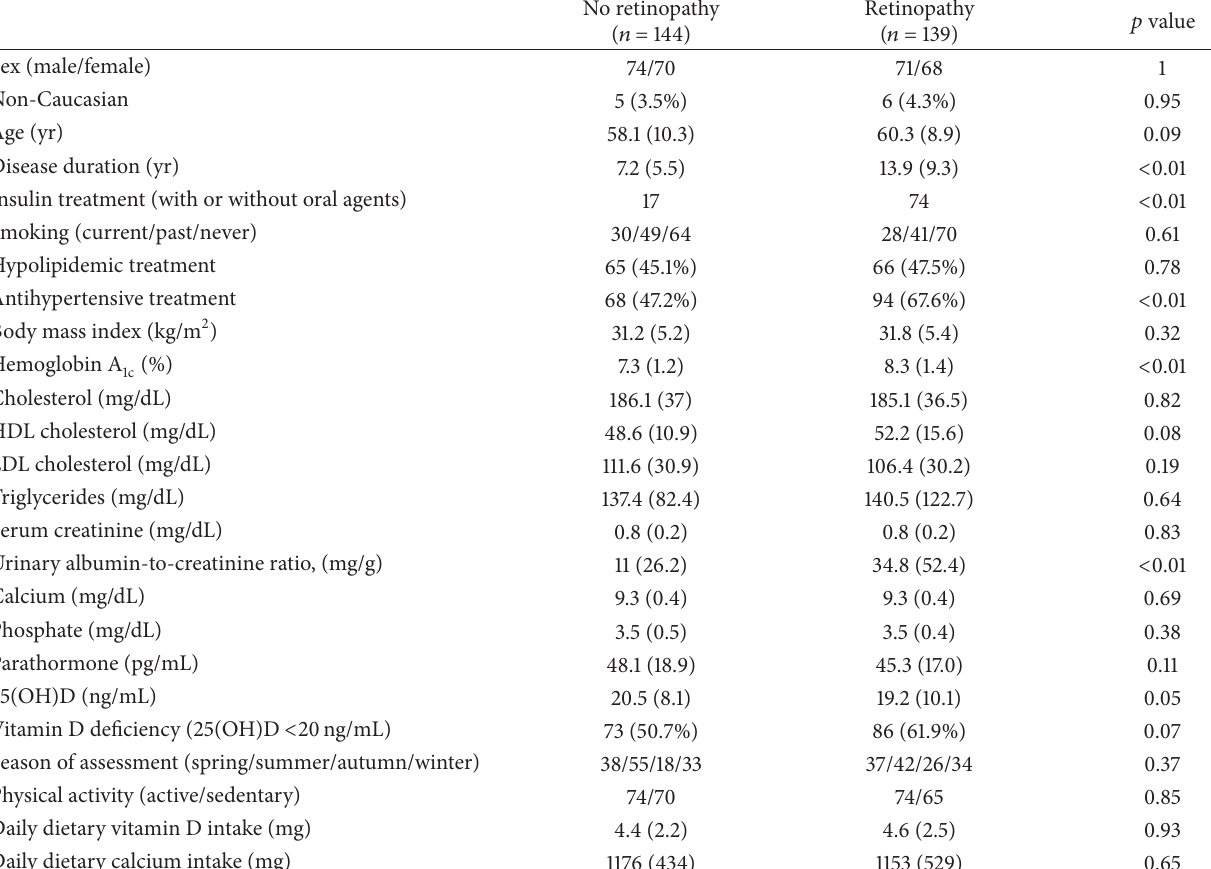
Table 1: Clinical and biochemical characteristics of patients with type 2 diabetes with and without